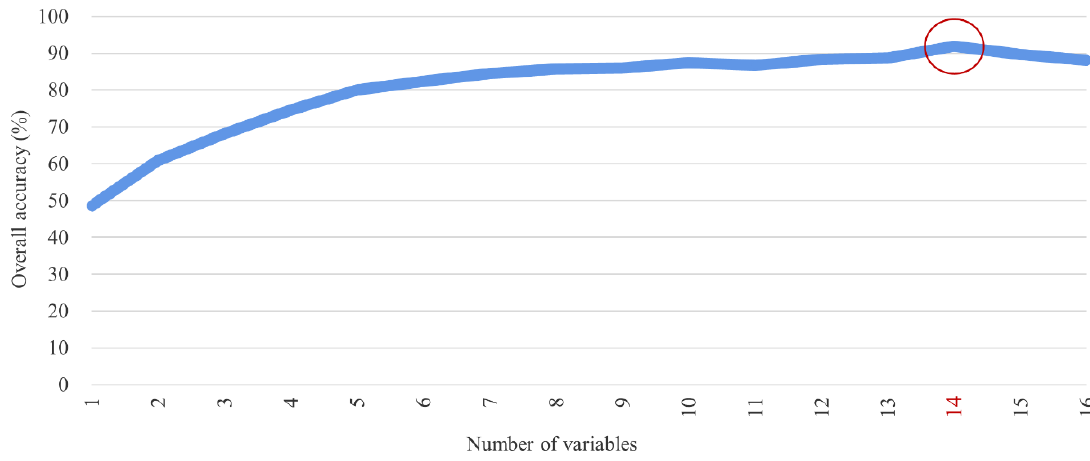
Figure 10. Changes in the OA values of UFZ classification with rising number of input variables.